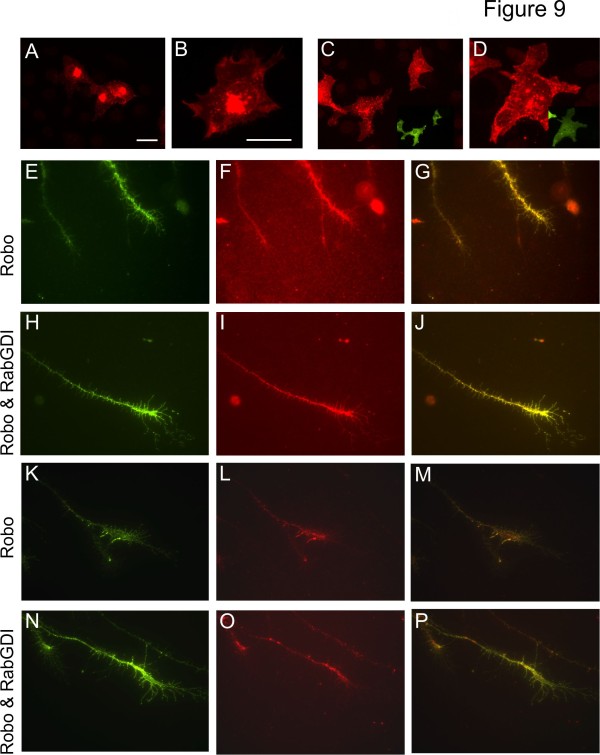
RabGDI triggers membrane insertion of Robo1. Robo1 expressed in COS cells was mainly found in the perinuclear area, the endoplasmic reticulum, and the Golgi apparatus (A and B). Co-transfection of RabGDI resulted in redistribution of Robo1 to vesicular structures in the periphery of the cells (C and D). Inserts show RabGDI expression. Note that the staining intensity in the perinuclear area was markedly decreased in the presence of RabGDI. To demonstrate surface expression of Robo1 in the presence of RabGDI commissural neurons dissected from HH21/22 chicken embryos expressing either HA-Robo1-myc alone (E-G and K-M) or in combination with RabGDI (H-J and N-P) were grown in culture. Growth cones shown in (E-J) and (K-P) were taken from independent experiments. Surface expression of Robo1 was visualized by staining the N-terminal HA-tag before fixation and permeabilization (E,H,K,N). The myc staining after fixation and permeabilization revealed total Robo1 levels (F,I,L,O). The overlay of both stainings is shown in G,J,M and P, respectively. In the presence of RabGDI 27.8% (p = 0.0051) more Robo1 could be detected on the surface of commissural axons. Bar: 10 μm.